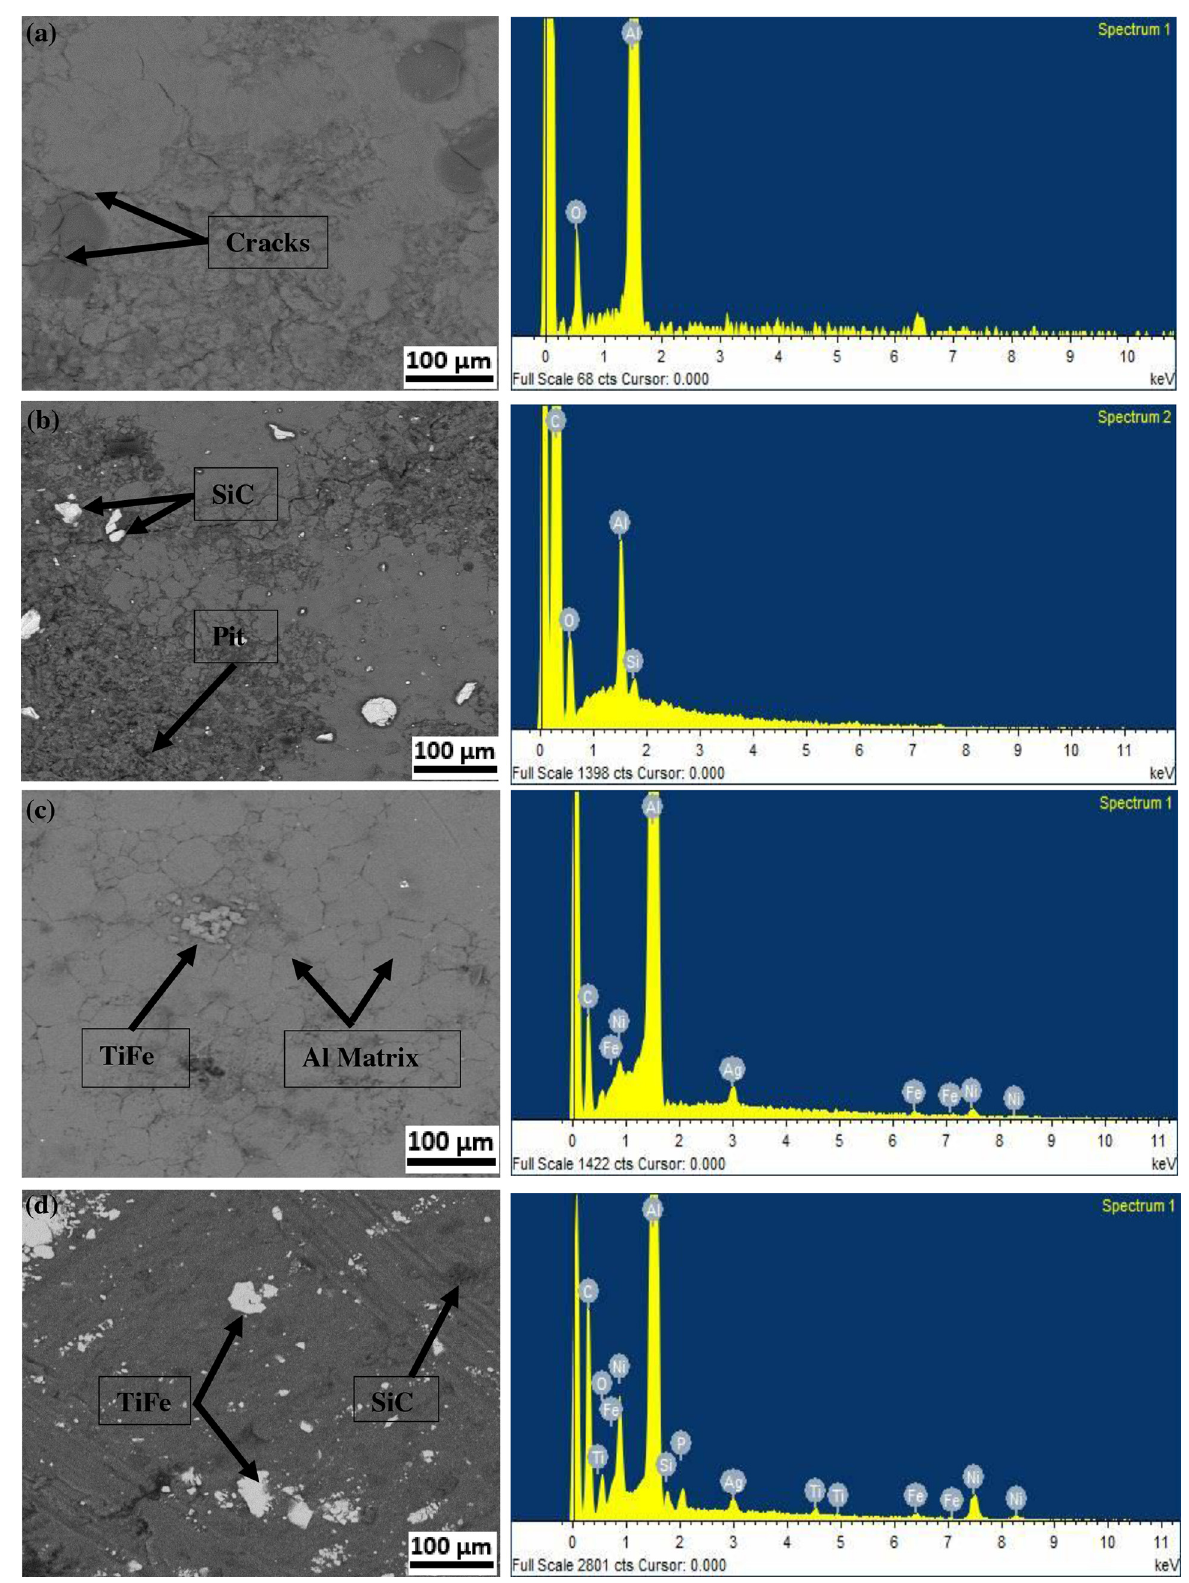
Fig. 4. SEM images of sintered (a) pure aluminium (b) Al +2% SiC (c) Al +5% TiFe (d) Al +5% SiC+2%